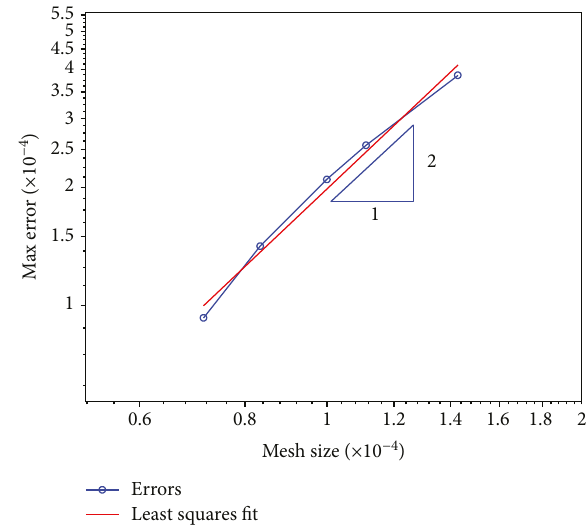
Figure 5: Spatial accuracy of the numerical discretization, with error represented in a log-log plot. The method is second-order accurate.